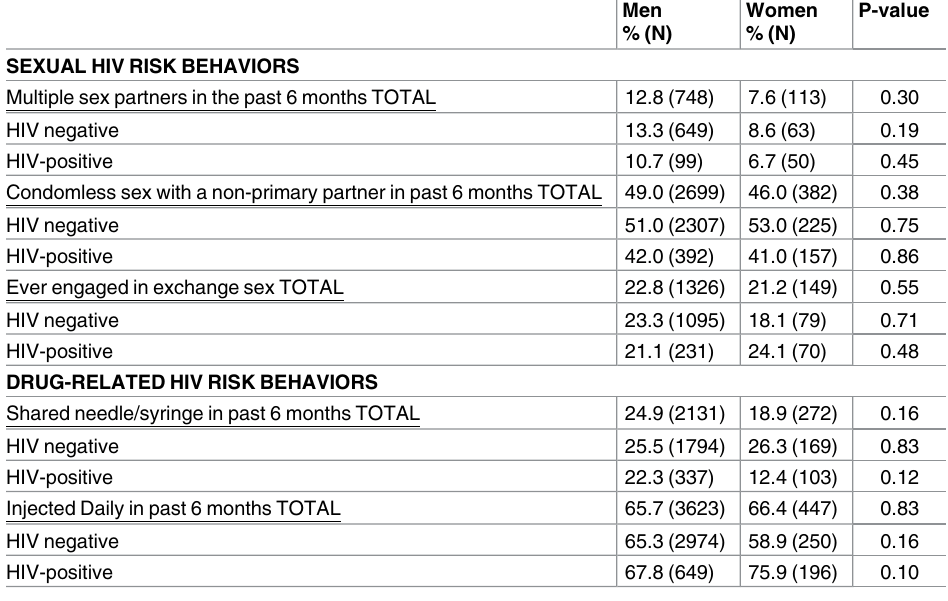
Table 2. Gender differences in sexual and drug-related HIV risk behaviors among men and women who inject drugs in seven cities in India (N = 6449).